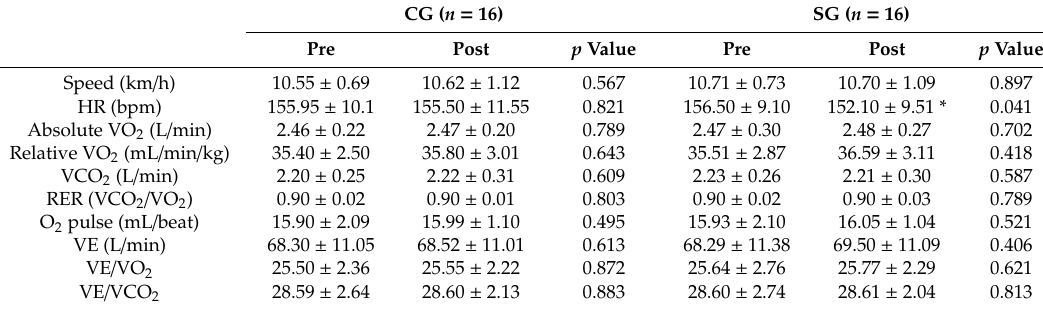
Table 4. Ergospirometric values corresponding to VT1.